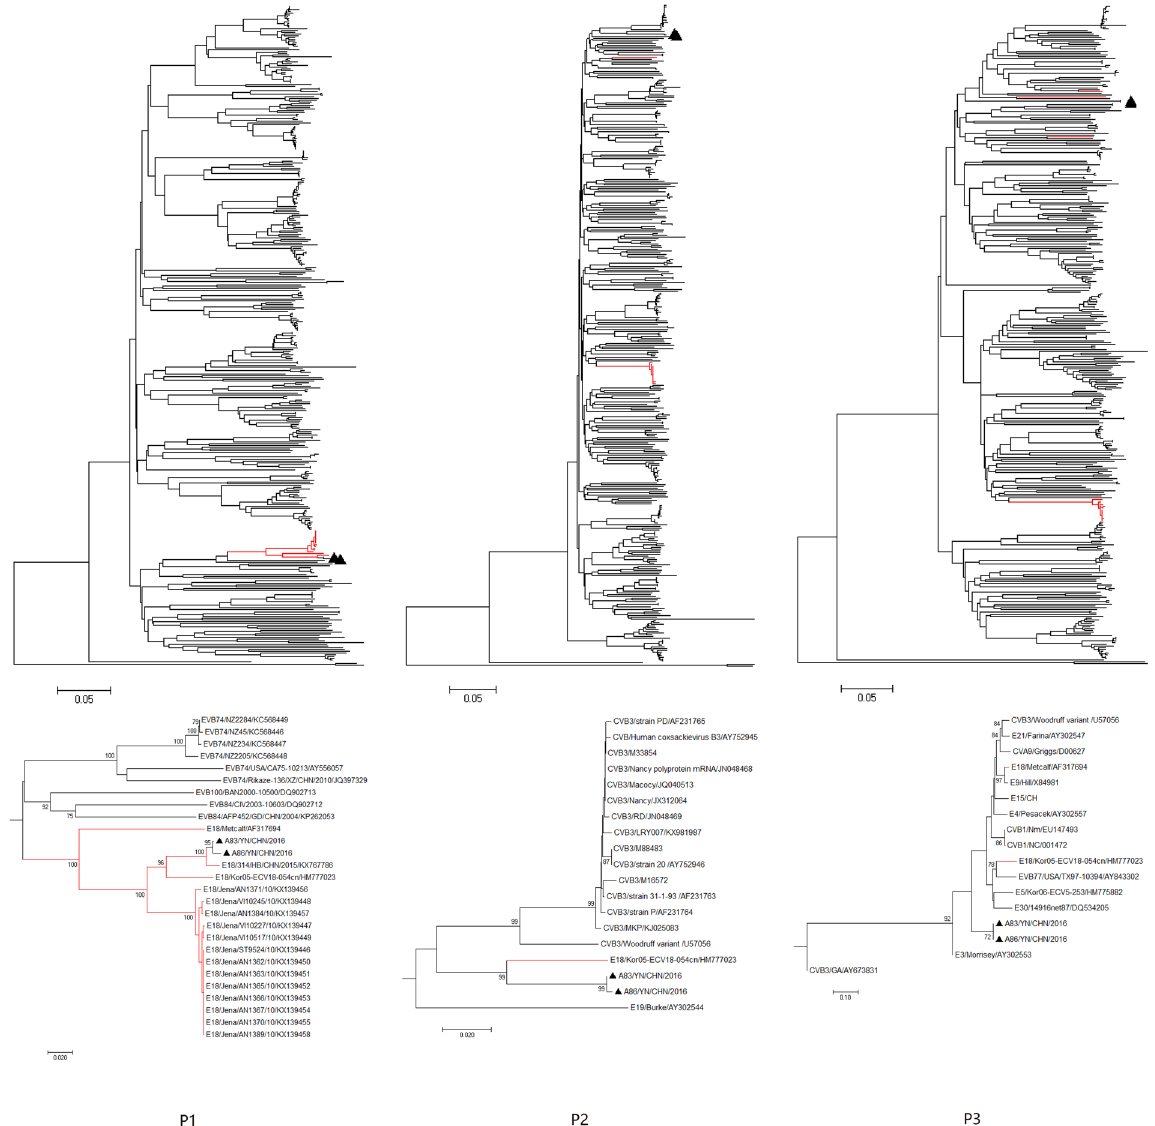
Figure 3. Phylogenetic relationships based on the P1 , P2 , and P3 coding sequences of 379 EV-B strains. Two E-18 strains and 377 EV-B strains available in GenBank database were analysed by nucleotide sequence alignment using the neighbor joining algorithms implemented in the MEGA 6.06 program. Numbers at the nodes indicate bootstrap support for that node (percentage of 1000 bootstrap replicates). The scale bars represent the genetic distance. Only high bootstrap values ( > 75%) are shown. Only high bootstrap values ( > 75%) are shown. ▲ Strains isolated in this investigation. Red denote the other E-18